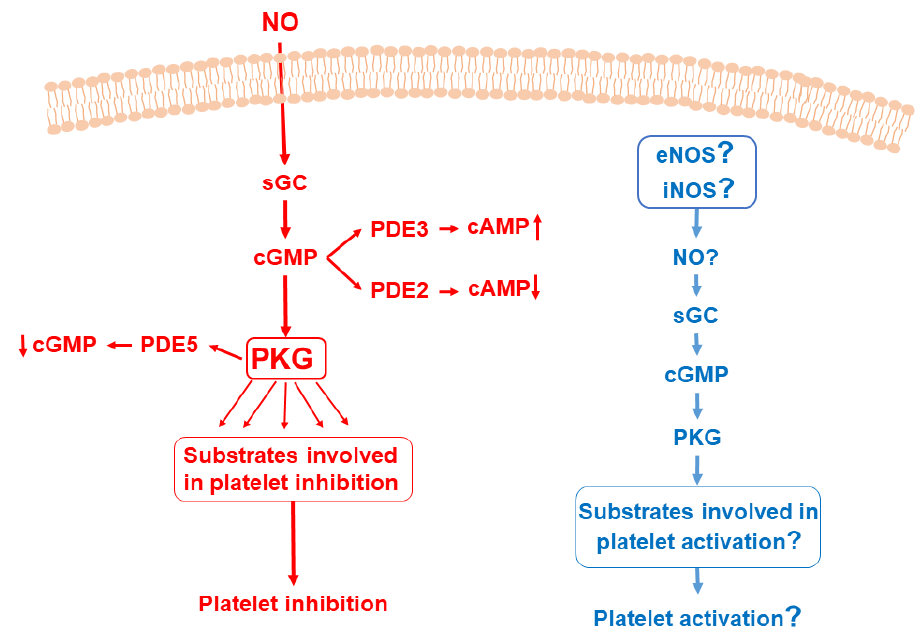
Figure 2. NO/sGC/cGMP/PKG pathways in platelets. (Part in red). Activation of sGC by endoge- nous NO increases cGMP synthesis. cGMP is involved in regulation of cAMP concentration by PDE2 and PDE3 activation. PDE5 is the main PDE responsible for cGMP degradation. Activated PKG leads to changes in phosphorylation status of numerous proteins and some of them (VASP, IRAG, Rap1B, Rap1Gap2, GRP2, IP3 receptor and others, for details see Section 3) are involved in platelet inhibitory pathways. An alternative hypothesis is presented in blue. However, the expression of any NOS isoform and whether platelets themselves could produce biologically active NO are still under question. In addition, until now, possible involvement of any PKG substrate in platelet stimulatory pathways was not shown (see Section 4.3).